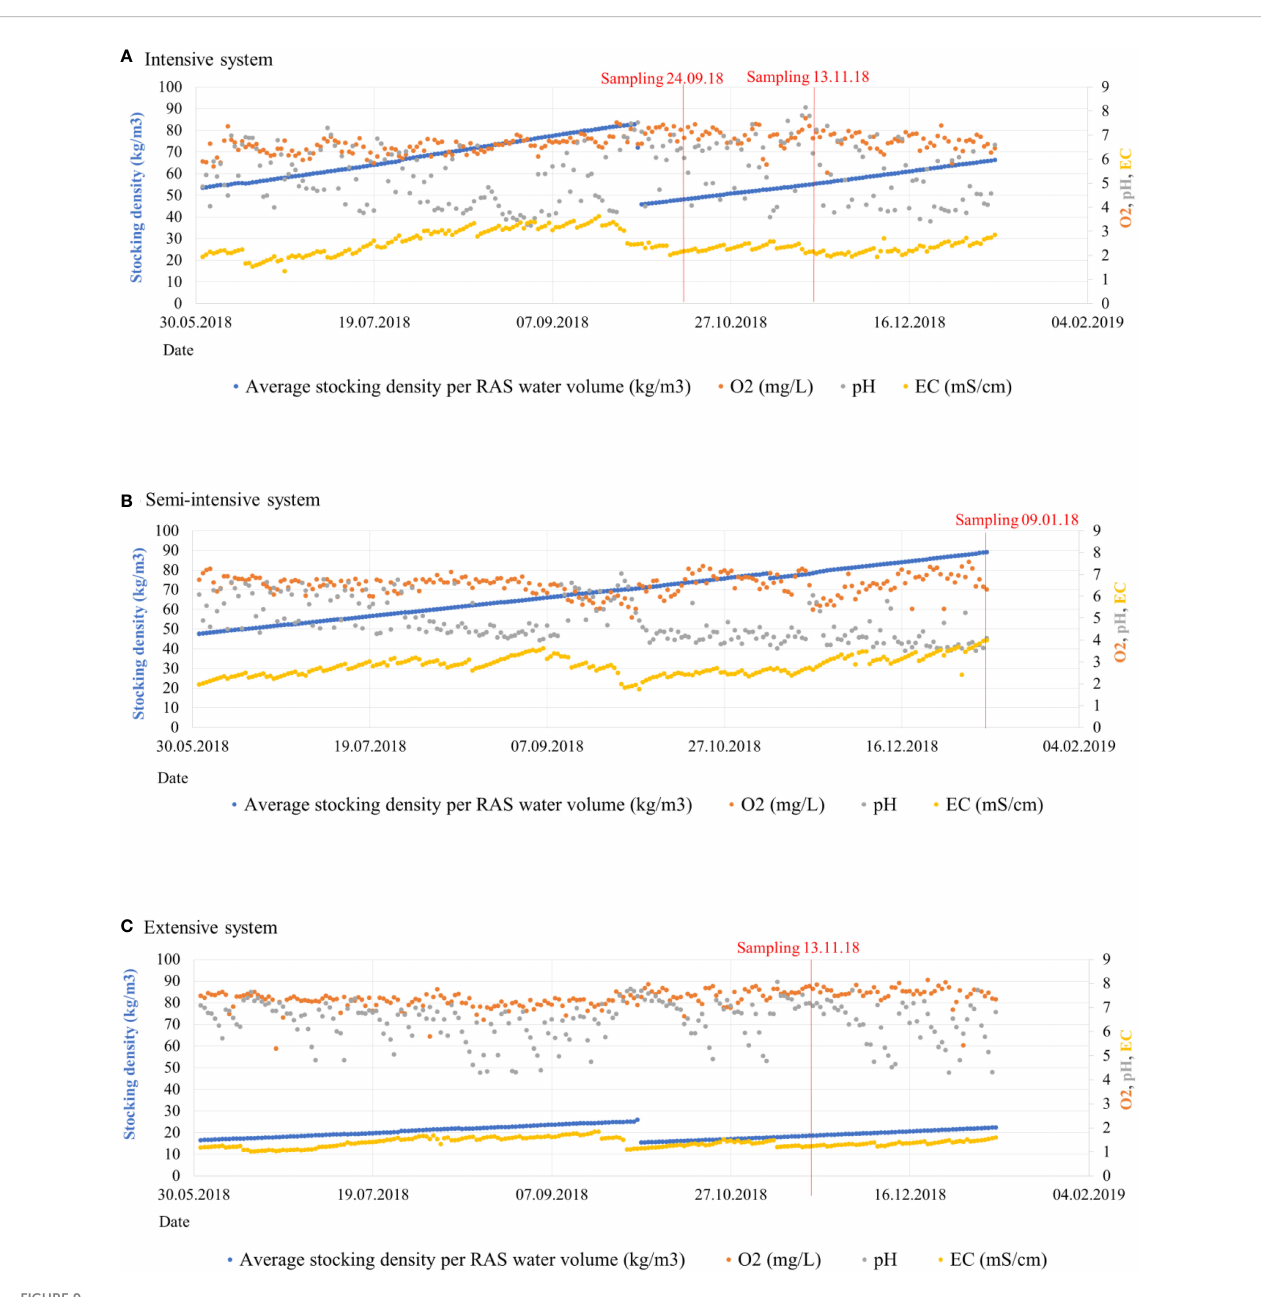
FIGURE 9 Fish stocking density (kg/m 3 ) of the three sampled systems ( A , medium-density system; B , high-density system; C , low-density system) before and after sampling represented in blue color. The red line indicates the date where each sample was obtained. Values of water dissolved oxygen (O 2 ) are represented in orange color, pH in grey and conductivity (EC) in